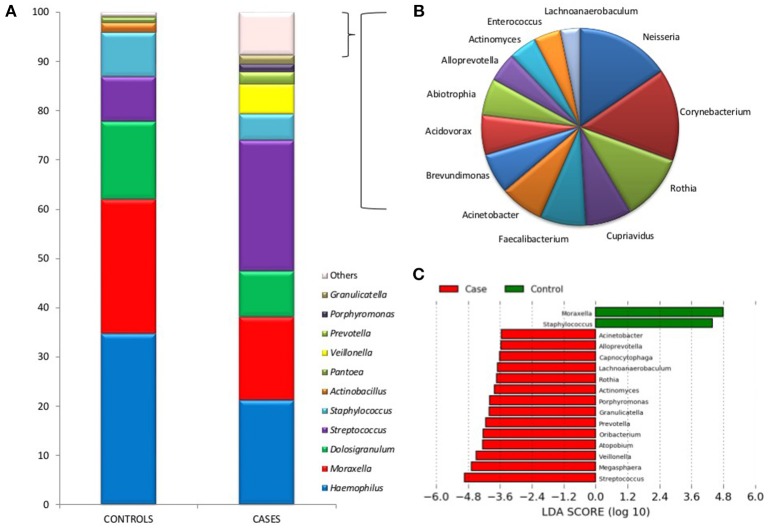
Bacterial taxonomic composition of nasopharyngeal samples in cases and controls. (A) Graphs show the mean proportion of the most frequent bacterial genera as inferred by PCR amplification and pyrosequencing of the 16S rRNA gene. The mean proportions were calculated based on 1,000 sequences per sample. Those bacteria at a proportion lower than 1% are indicated as “Others” and were particularly abundant in cases. (B) Shows a description of those low-frequency bacteria in patients with IPD, which include many oral organisms (bacteria at a proportion <0.2% are not shown). (C) A Linear Discriminant Analysis Effect Size (LEfSe) analysis shows those bacteria with significantly different levels (α = 0.05) between cases and controls.